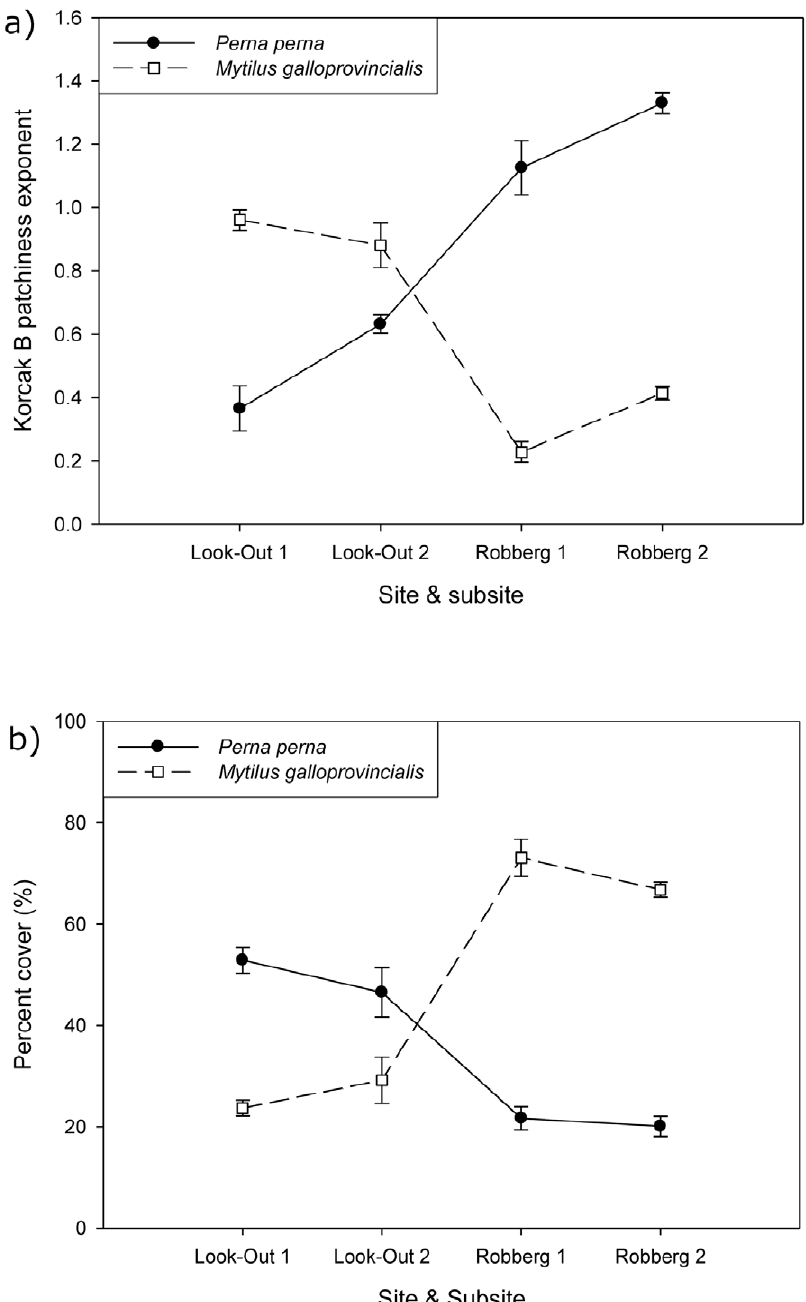
Figure 2. Differences in a) patchiness and b) mussel cover between the sites (Look-Out; Robberg) and sub-sites.